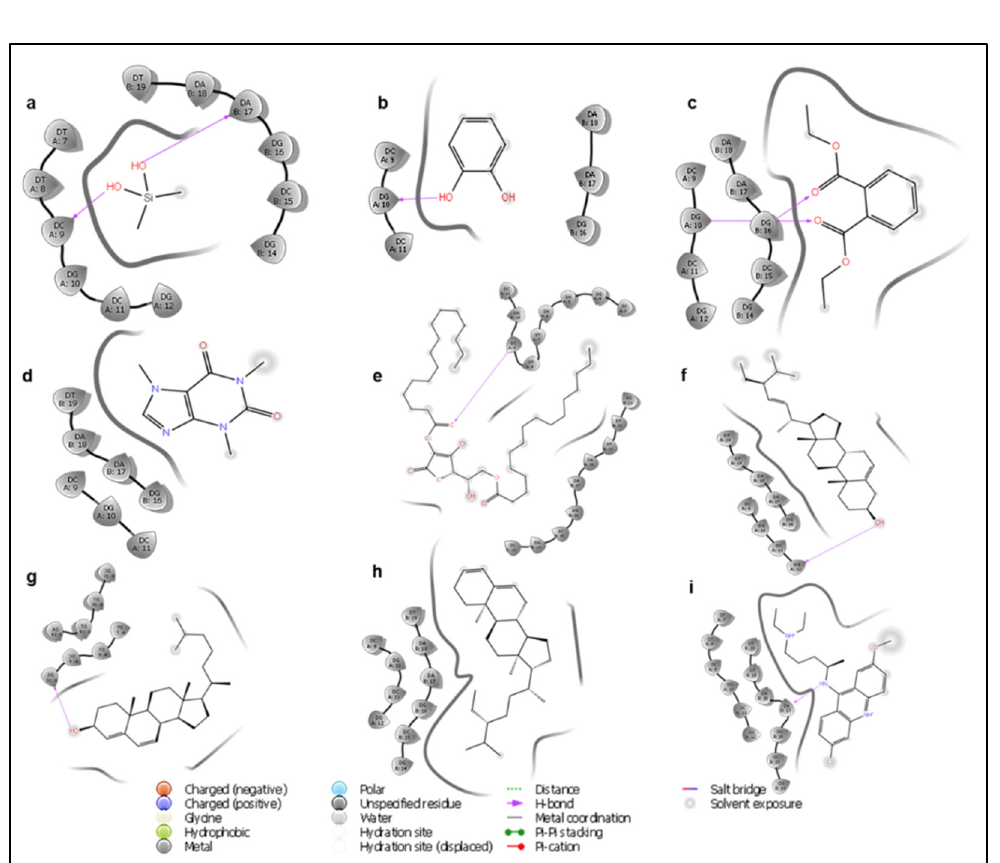
Figure 9. 2D ligand interaction diagram of dimethyl silanediol ( a ), catechol ( b ), diethyl phthalate ( c ), caffeine ( d ), l-(+)-ascorbic acid 2,6-dihexadecanoate ( e ), stigmasterol ( f ), cholesta-4,6-dien-3beta-ol ( g ), stigmastan-3,5-diene ( h ), and quinacrine ( i ) with B-DNA.